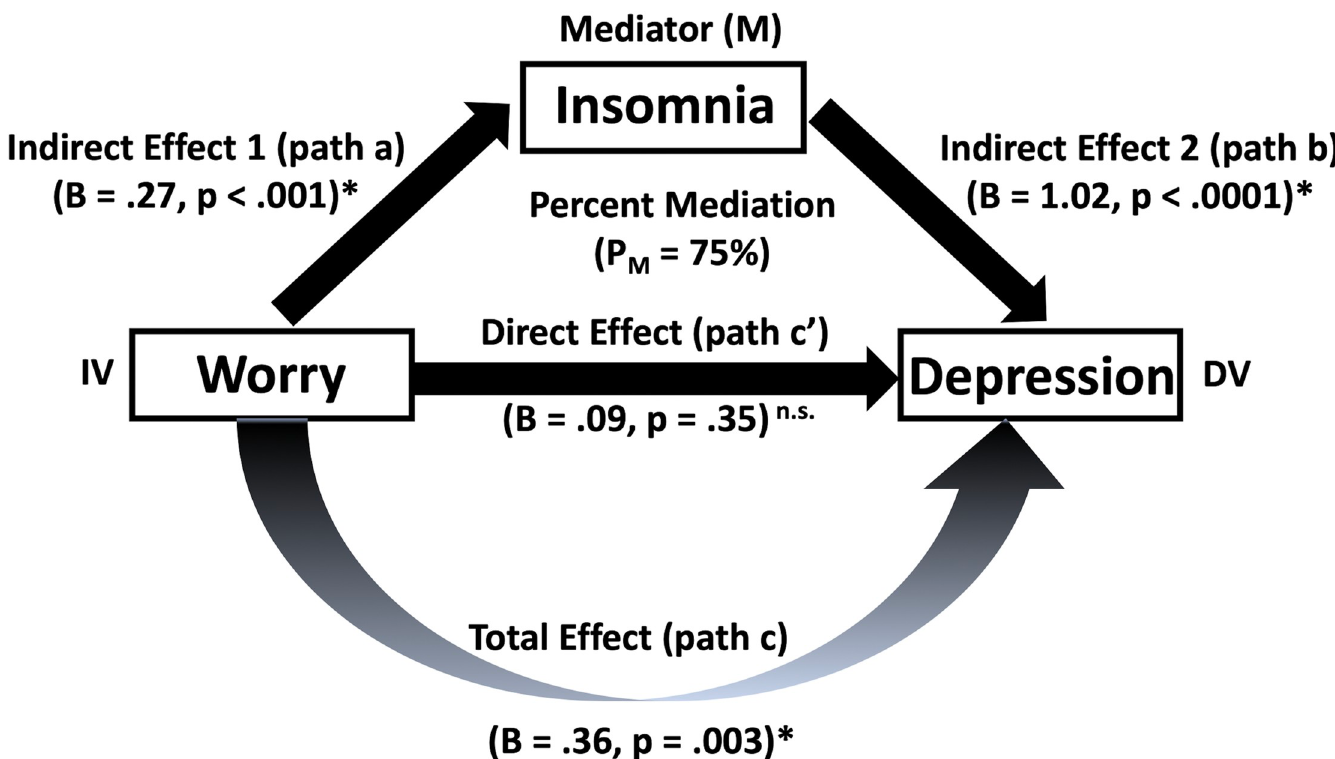
Fig 1. Mediation analysis. An illustration of the path model (model 4) used to test the mediation effect of insomnia (M) on the association of worry score (independent variable, IV) with depression (dependent variable, DV). Path model shows complete mediation effect of insomnia, with percent mediation (P M ) of 75%. B, unstandardized beta coefficients; � p < . 005